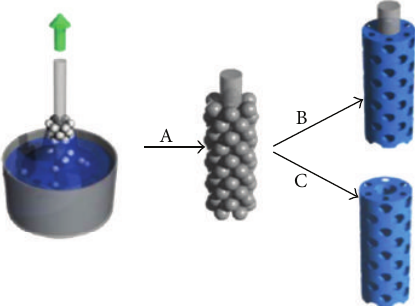
Figure 12: Schematic illustration of the self-assembly of colloidal spheres on a cylindrical glass fiber (A) and the inverted structure with glass fiber core (B), respectively, with hollow core (C)